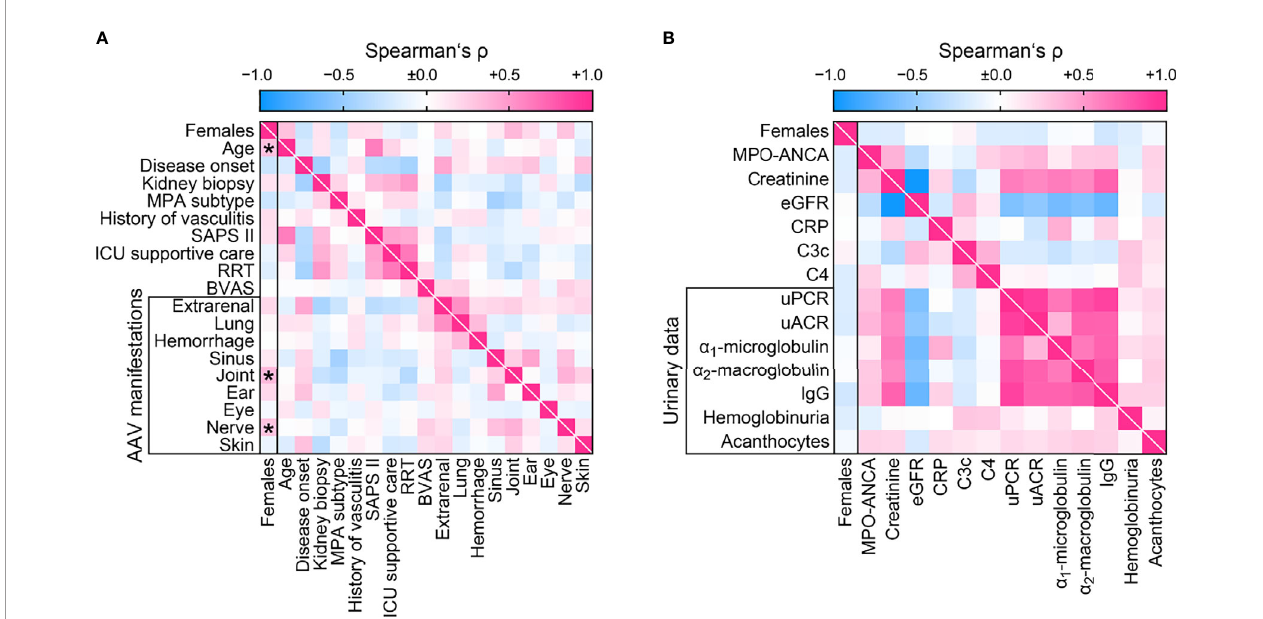
FIGURE 2 | Sex differences among clinical characteristics and laboratory parameters at disease manifestation in AAV. (A) Sex in association with clinical fi ndings are shown by heatmap re fl ecting mean values of Spearman ’ s r , asterisks indicate p < 0.05 . (B) Sex in association with laboratory parameters are shown by heatmap re fl ecting mean values of Spearman ’ s r . AAV, ANCA-associated vasculitis; ANCA, anti-neutrophil cytoplasmic antibodies; BVAS, Birmingham Vasculitis Activity Score; C3c, complement factor 3 conversion product; C4, complement factor 4; CRP, C-reactive protein; eGFR, estimated glomerular fi ltration rate; IgG,